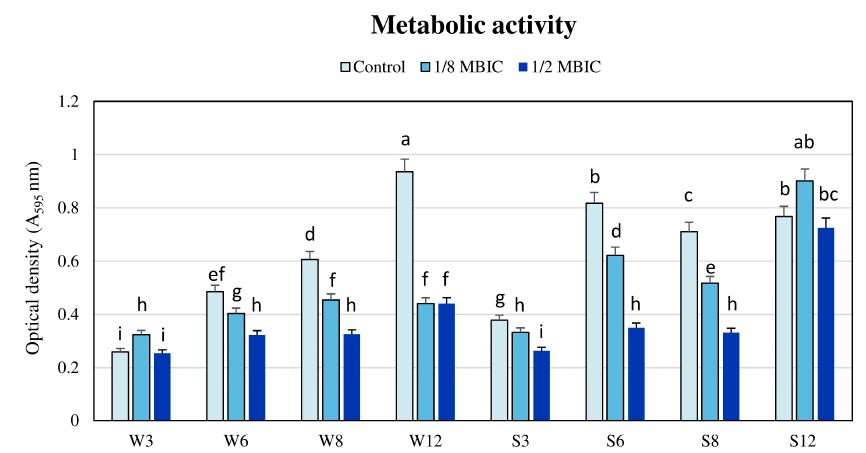
Figure 1. Metabolic activity of biofilms formed by MRSA strains in the presence of TC at concentrations ⅛ and ½ minimum biofilm inhibition concentration (MBIC) in different time